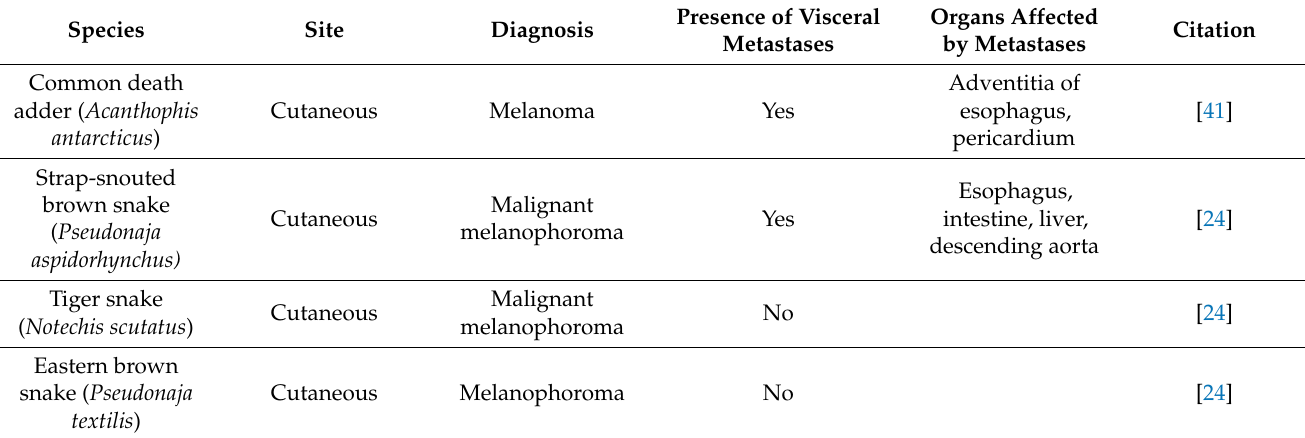
Table 11. Clinical features of chromatophoromas in the reptile family: Elapidae